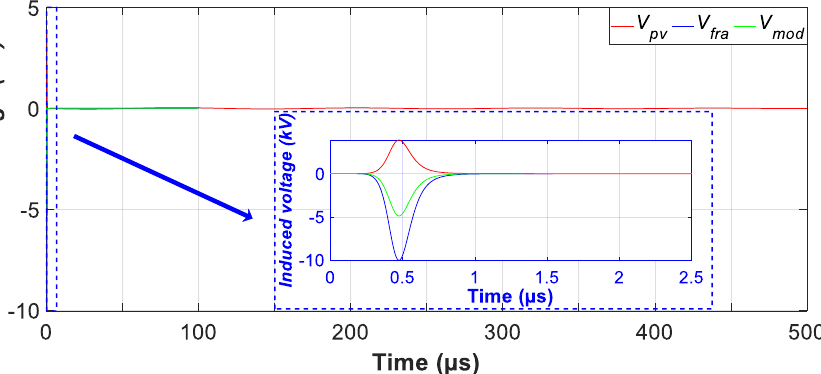
Figure 13. Case of subsequent short stroke, induced voltages at the PV module. Vertical strike hitting 5 m away from the module.